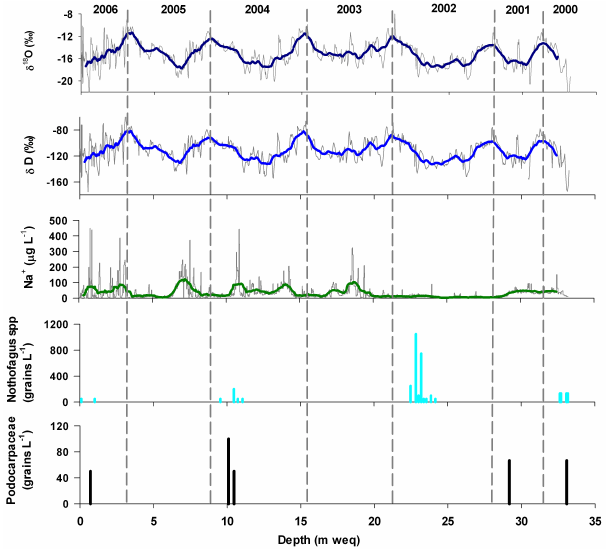
Fig. 4. Pío XI ice core stable isotope ratios δ 18 O, δ D (raw data and 29 point moving average), Na + concentration (raw data and 29 point moving average), and pollen records. Proposed attribution of years is indicated with vertical dashed lines.